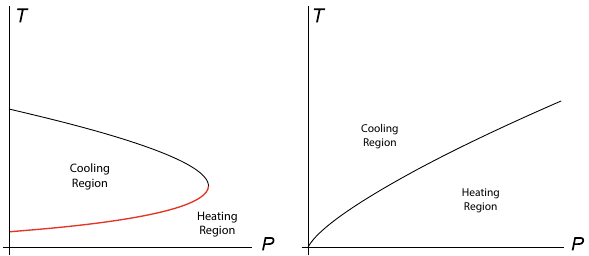
Fig. 3 (Left) Inversion curves for van der Waals fluids. Red thick line and black solid line correspond to lower and upper inversion curves, respectively. (Right) Lower inversion curves for the charged AdS and Kerr–AdS black